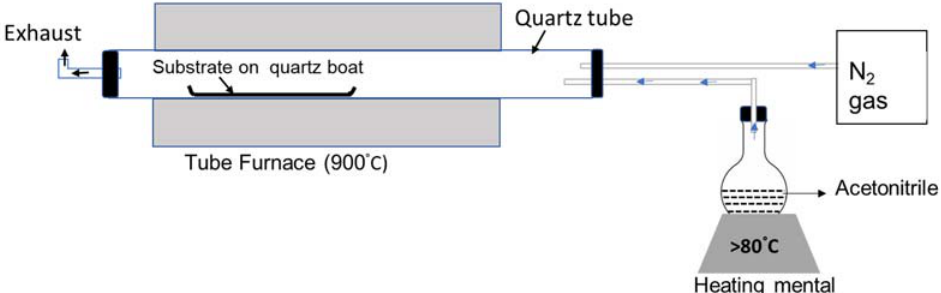
Figure 1. Schematic for synthesis of N-doped pseudo-graphite using a modified CVD technique.